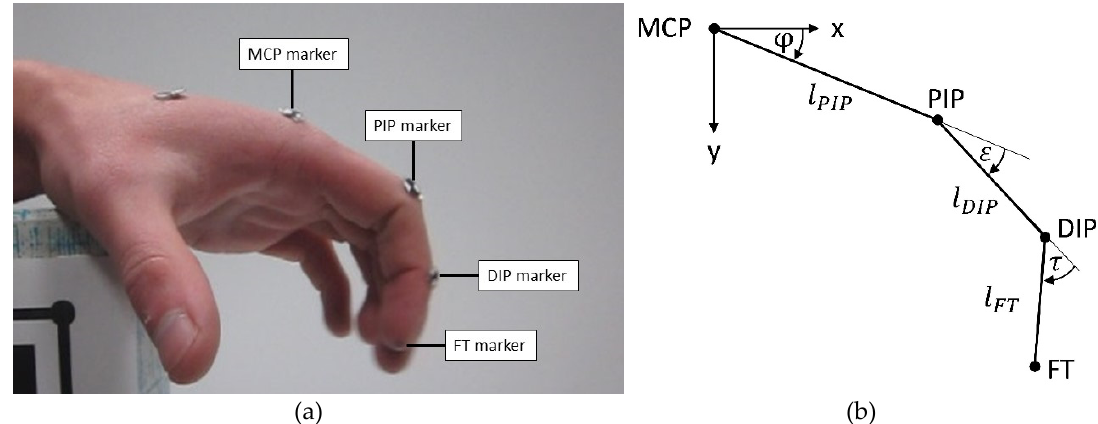
Figure 3. Experimental setup for finger motion video tracking ( a ) and definition of angles of the finger joints ( b ).